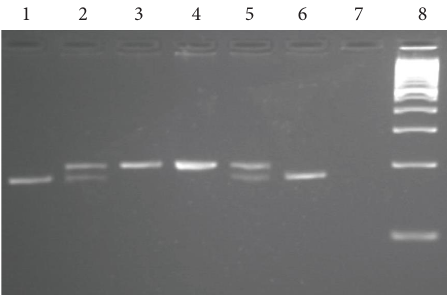
Figure 1: Genotypic profles of the C677T polymorphism of MTHFR on agarose gel. Lane 8 represents DNA ladder; lanes 3 and 4 represent CC wild type; lanes 2 and 5 represent CT heterozygous; lanes 1 and 6 represent TT-mutated